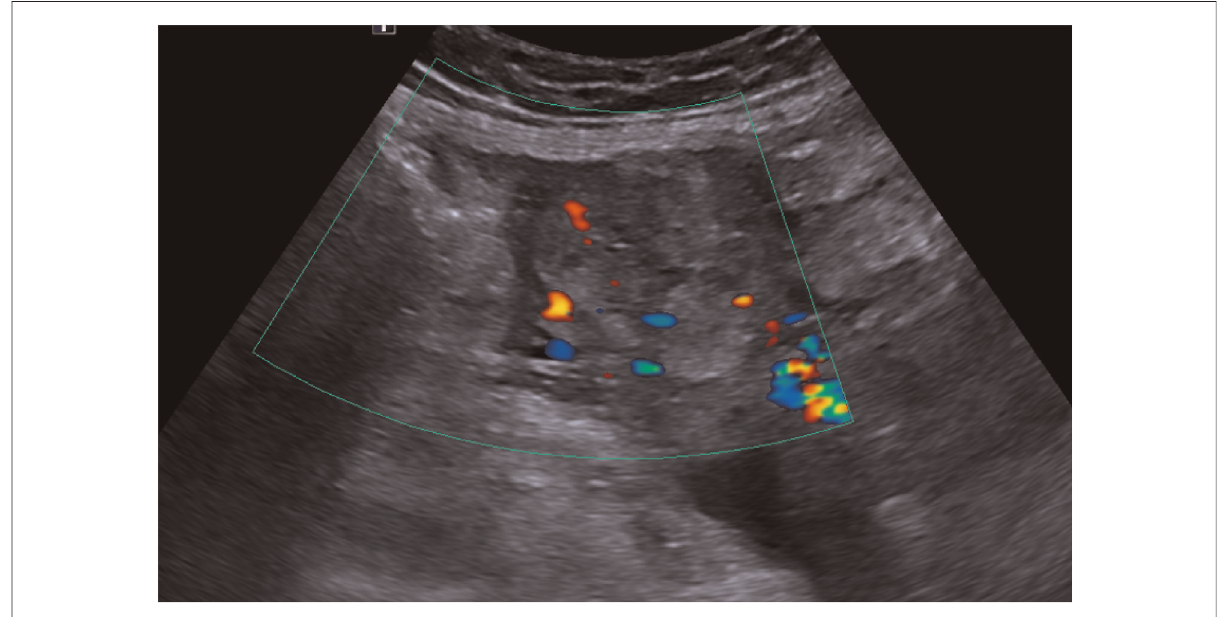
FIGURE 1 Ultrasonographic appearance of the left adnexal mass: scarce colour Doppler fl ow in the left adnexal mass. The effectiveness of color- fl ow Doppler in the setting of a molar pregnancy is considered debatable. The typical fi nding of a molar pregnancy are the multiple small vesicles in a hyperechoic mass which classically give a “ snowstorm ”